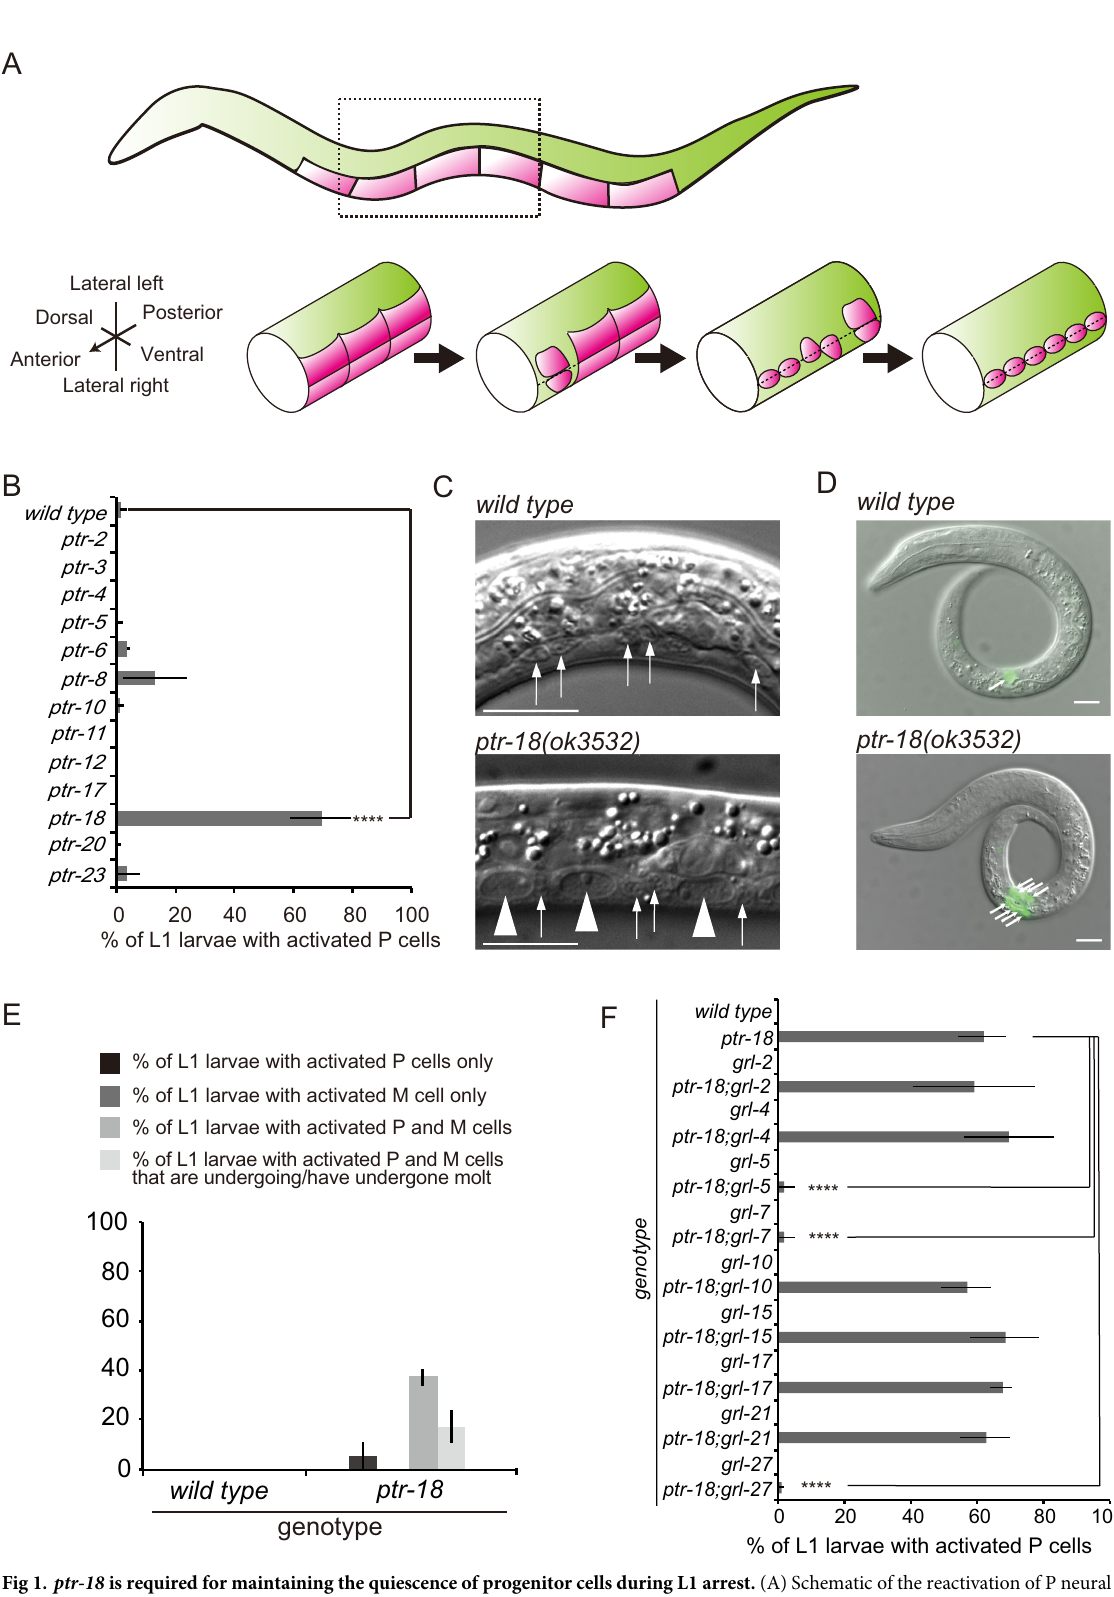
Fig 1. ptr-18 is required for maintaining the quiescence of progenitor cells during L1 arrest. (A) Schematic of the reactivation of P neural progenitor cells. Drawings were made based on https://www.wormatlas.org/hermaphrodite/hypodermis/Hypframeset.html. Top: A